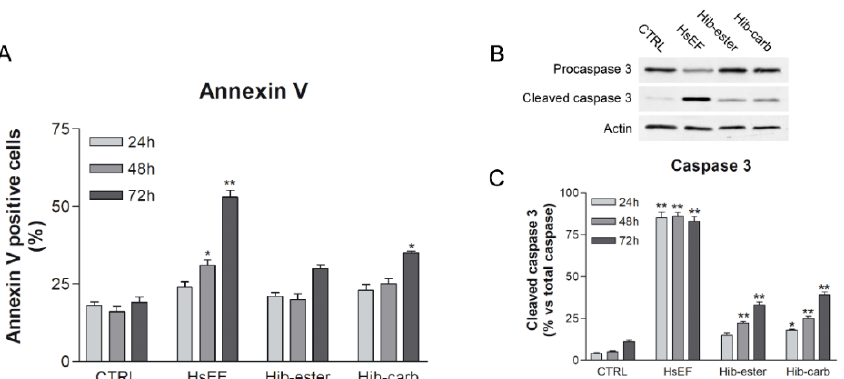
Figure 5. RPMI 8226 cells apoptosis. ( A ) Annexin V positive cells after treatment with HsEF 3 mg/mL, Hib-ester 450 µ g/mL and Hib-carbaldehyde 200 µ g/mL for 24, 48 and 72 h. ( B ) Representative images and ( C ) quantification of caspase 3 Western blotting. Data are represented as the mean percentage ± SD, compared to untreated RPMI 8226 cells (CTRL) (* p < 0.05, ** p < 0.01 vs. CTRL).